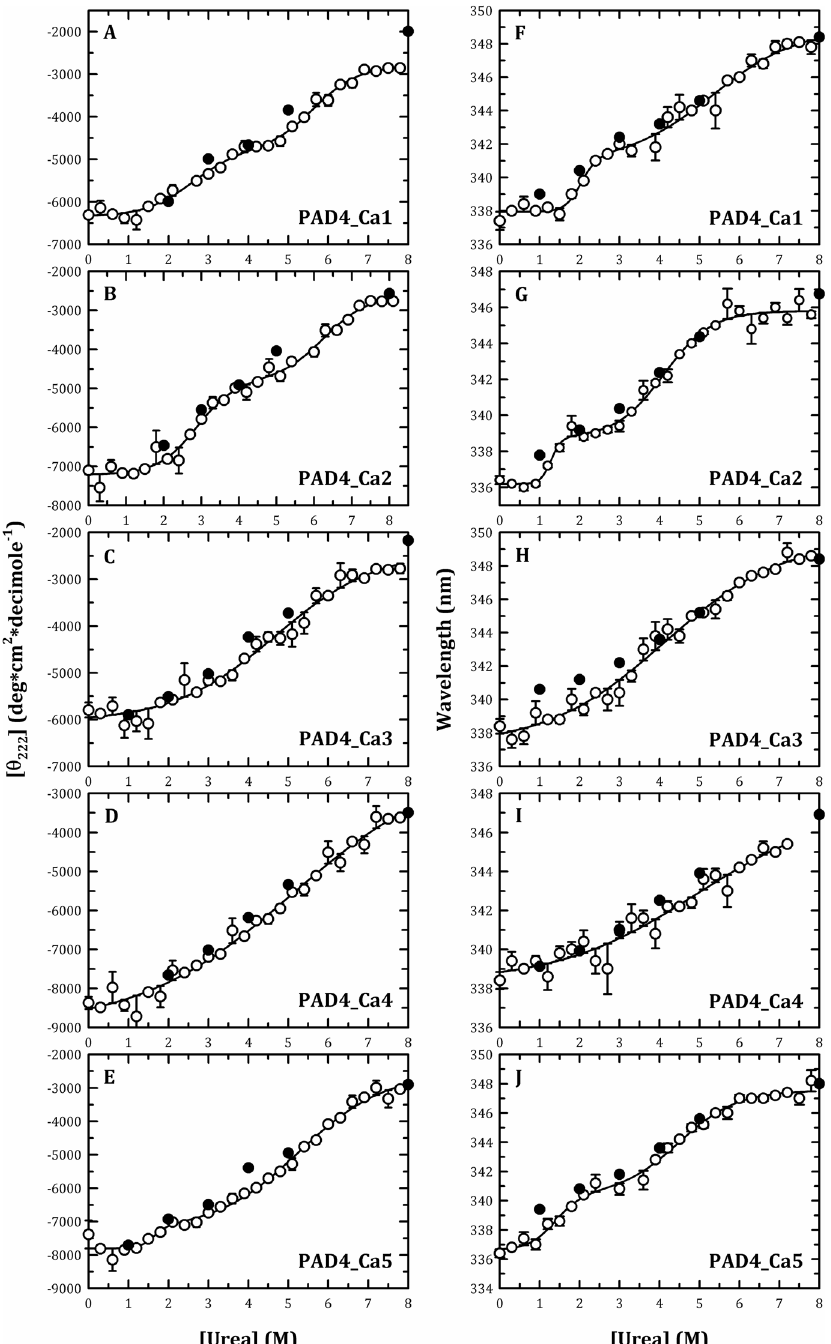
Figure 5. Monitoring of the urea-induced unfolding and refolding of the human PAD4 calcium-binding-site mutant enzymes by CD spectrometry and the intrinsic protein fluorescence. The PAD4 calcium-binding-site mutant enzymes in the presence of 10 mM Ca 2 + were treated with various concentrations of urea in 50 mM Tris-HCl buffer (pH 7.4) at 25 °C for 16 h and then monitored through CD spectrometry (Panels (A–E)) or fluorescence (Panels (F–J)). Panels (A and F) PAD4_Ca1. Panels (B and G) PAD4_Ca2. Panels (C and H) PAD4_Ca3. Panels (D and I) PAD4_Ca4. Panels (E and J) PAD4_Ca5. Open circles: the PAD4 enzyme was denatured with different concentrations of urea. Closed circles: the PAD4 enzyme was completely denatured with 8 M urea and then renatured by diluting the urea concentration as indicated in the figures. All the data were fitted by either a two-state or three-state model. The fit results and residues are shown as a solid line with error